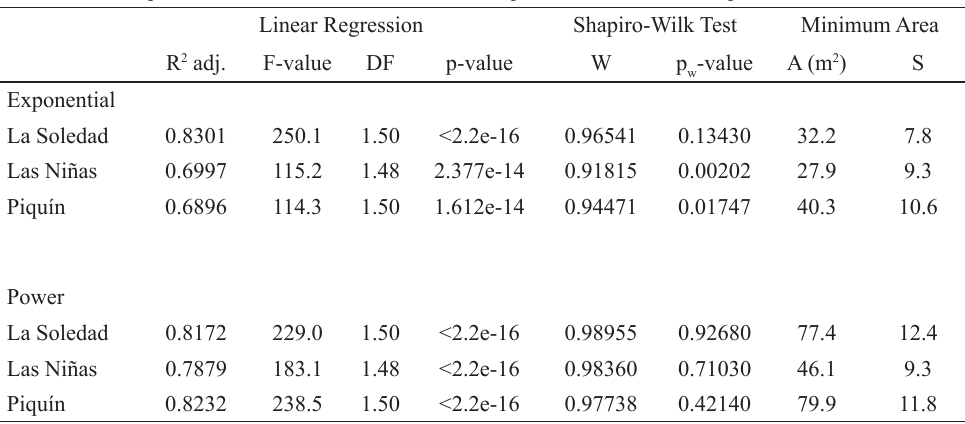
Table 2. Output statistics and normality of residuals for linear models describing the species-area relationship at each site. It includes both exponential (log-transformed area, species richness) and power (log-transformed area, log-transformed richness) model s, as well as minimum area values (and corresponding species richness, S) for the respective species-area curves in the real scale. The table also includes the output for Bartlett tests revealing variance in richness and log-transformed richness is homogeneous across the site categories. Exponential: Bartlett’s K-squared = 0.044635, df = 2, p-value = 0.9779; Power: Bartlett’s K-squared = 2.7953, df = 2, p-value =